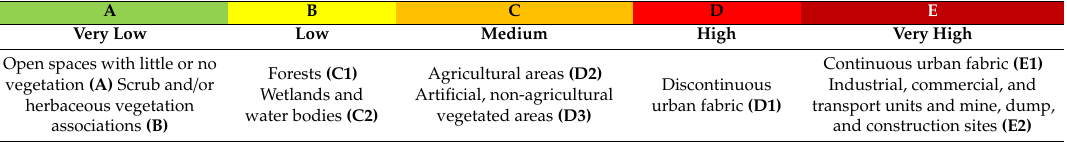
Table 3. Land use economic value according to the Land Use Map of the Andalusia Regional Administration. Codesoflanduses(i.e., “A”, “B”, “C1”, “C2”,